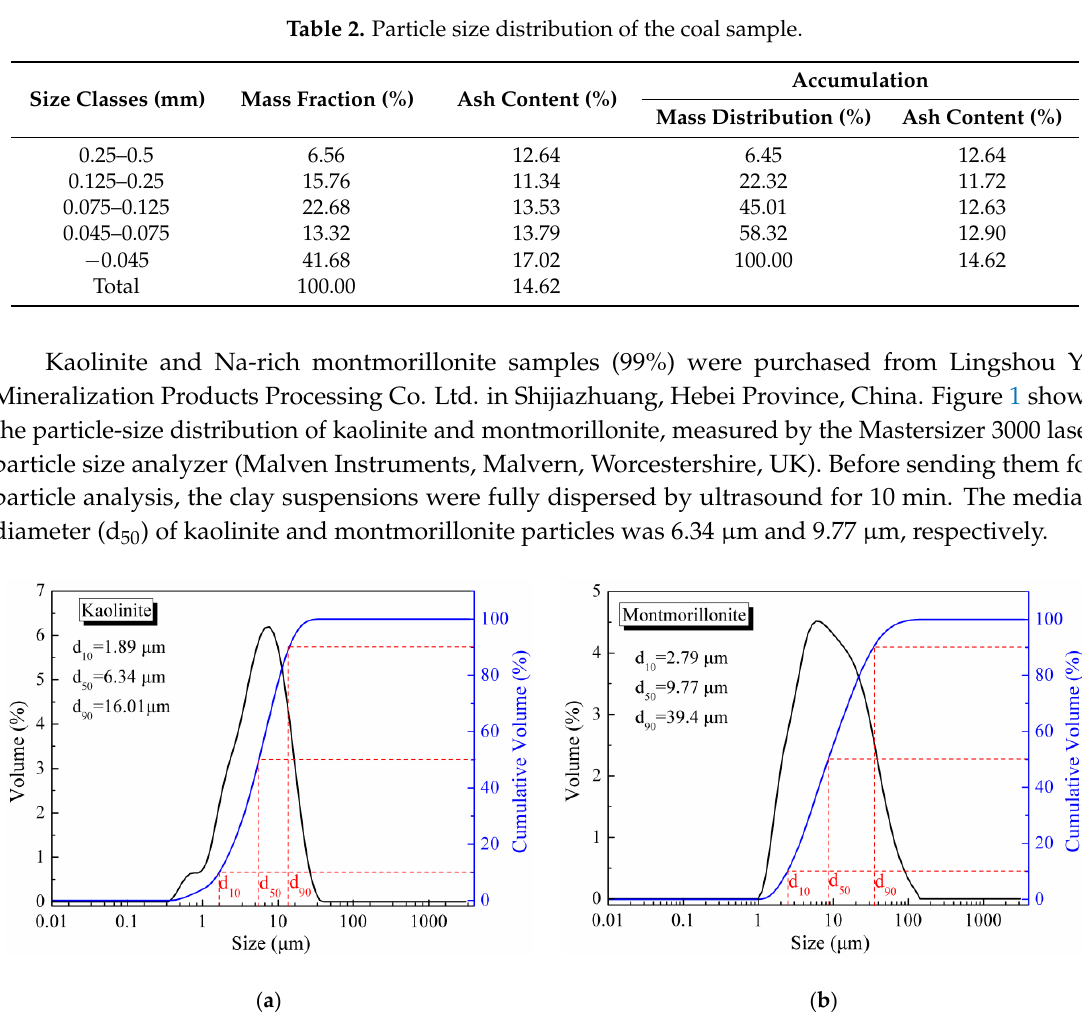
Table 2. Particle size distribution of the coal sample.